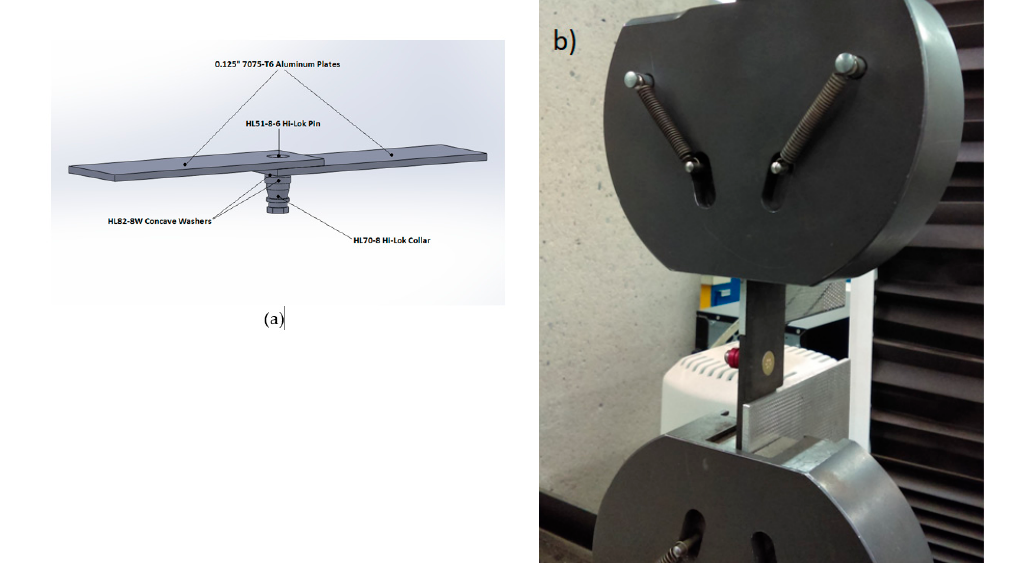
Figure 2. Static shear test assembly ( a ) aluminum joint for repeated collar installation and ( b ) steel shear test fixture installed in test machine.